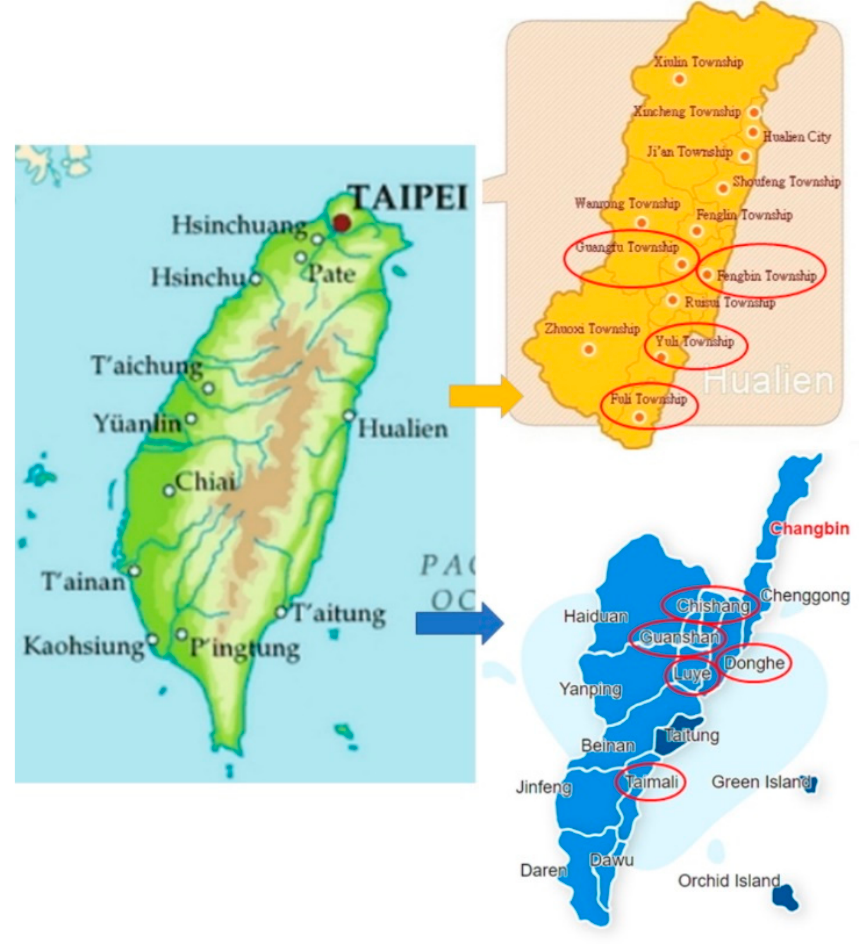
Figure 1. Study area—Taiwan’s Hualien and Taitung.